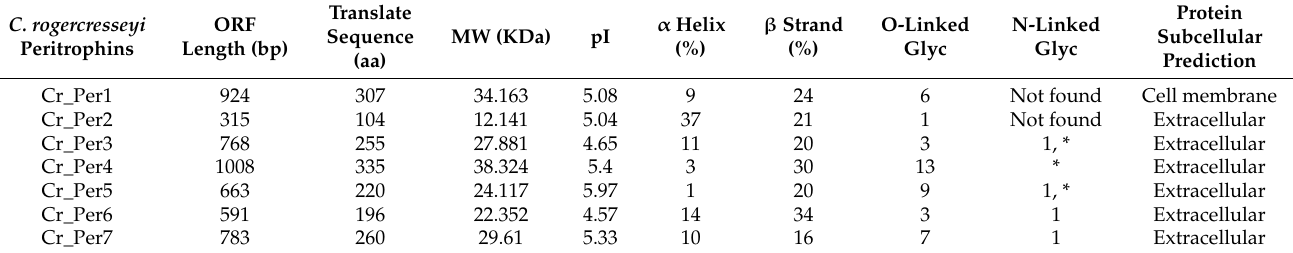
Table 1. C. rogercresseyi peritrophins characterization.